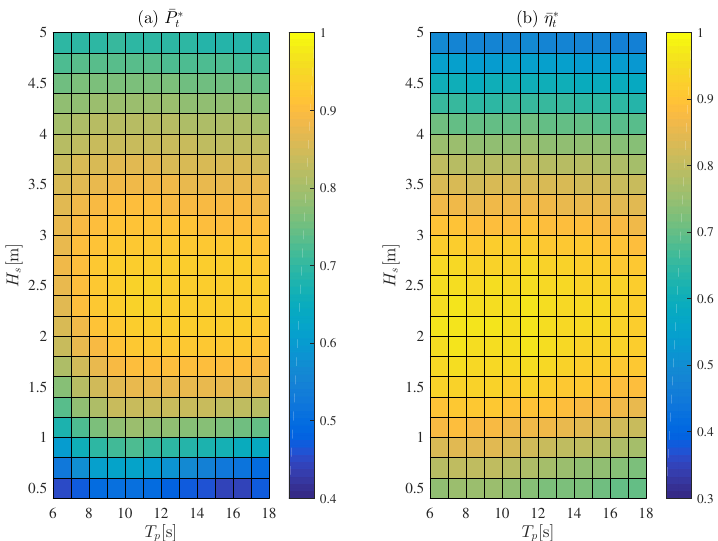
Figure 15. Time averaged results of the CAV controller under the PM irregular wave model with various T p and H s for T m = 5000 s when Ω d = 400 rad/s: ( a ) relative power extraction from turbine; ( b ) relative average turbine efficiency.